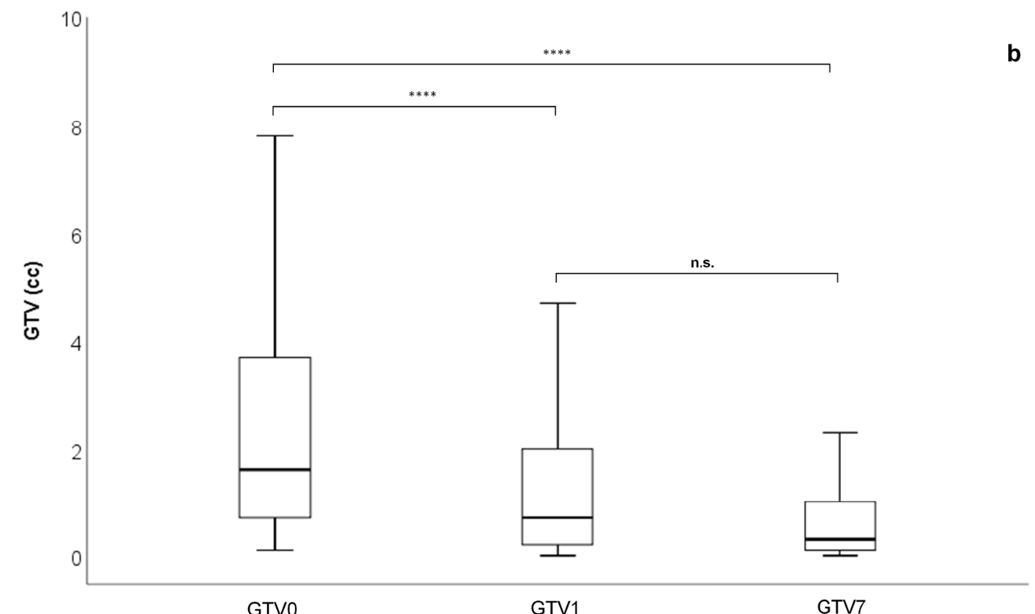
Figure 2. Change in volume ( a ) of total tumour bulk per patient ( N = 124). Pre-HFRT volume is significantly greater than at one month post-HFRT ( p < 0.001, ****) and seven months post-HFRT ( p < 0.001, ****). Volume at one month is significantly greater than at seven months post-HFRT ( p < 0.001, ****). ( b ) of each metastasis ( N = 233). Pre-HFRT volume is significantly greater than at one month post-HFRT ( p < 0.001, ****) and is significantly greater than seven months post-HFRT ( p < 0.001, ****). Volumes at one month and seven months post-HFRT are not significantly different to each other ( p = 0.224, n.s.). GTV0 = volume pre-treatment, GTV1 = volume at one month post-HFRT, GTV7 = volume at seven months post-HFRT, HFRT = hypofractionated stereotactic radiotherapy.